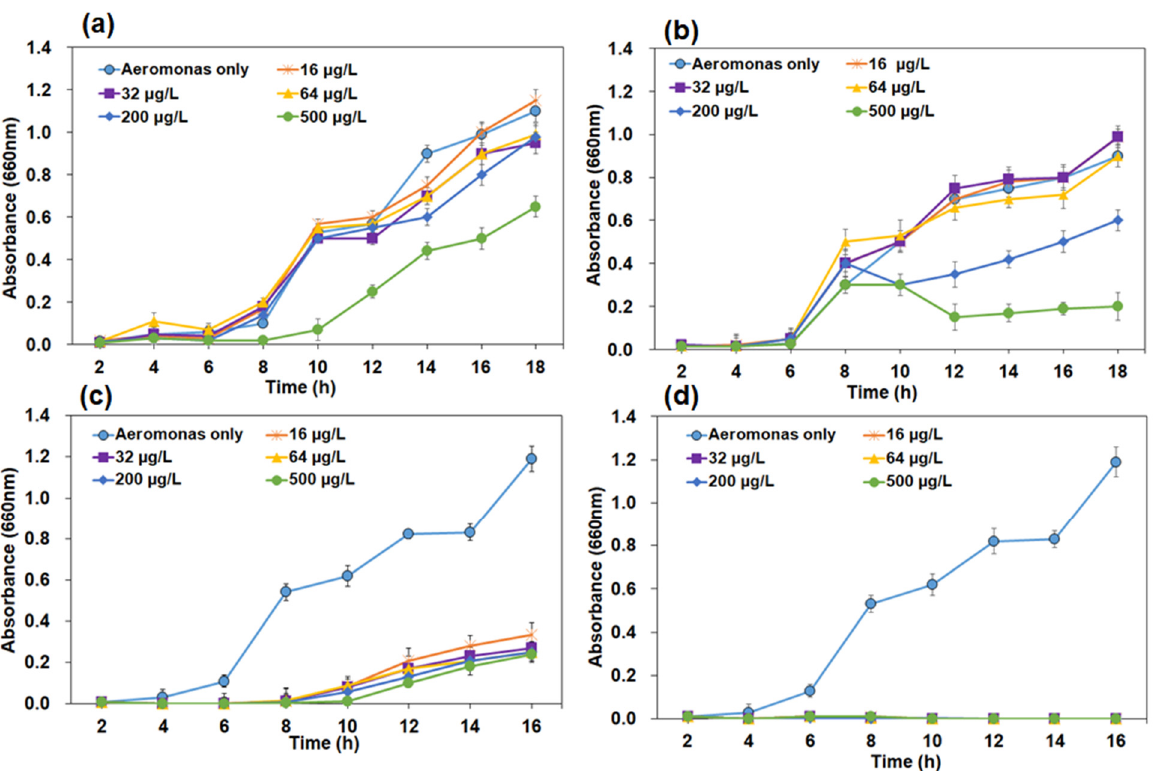
Figure 2. Antibiotic susceptibility pattern of Aeromonas (01Tet-2-1-2-27FD08) at 16, 32, 64, 200, and 500 μ g/mL concentrations, OD values at 660 nm. ( a ) Tetracycline, ( b ) Penicillin, ( c ) Colistin and ( d ) Kanamycin, respectively.